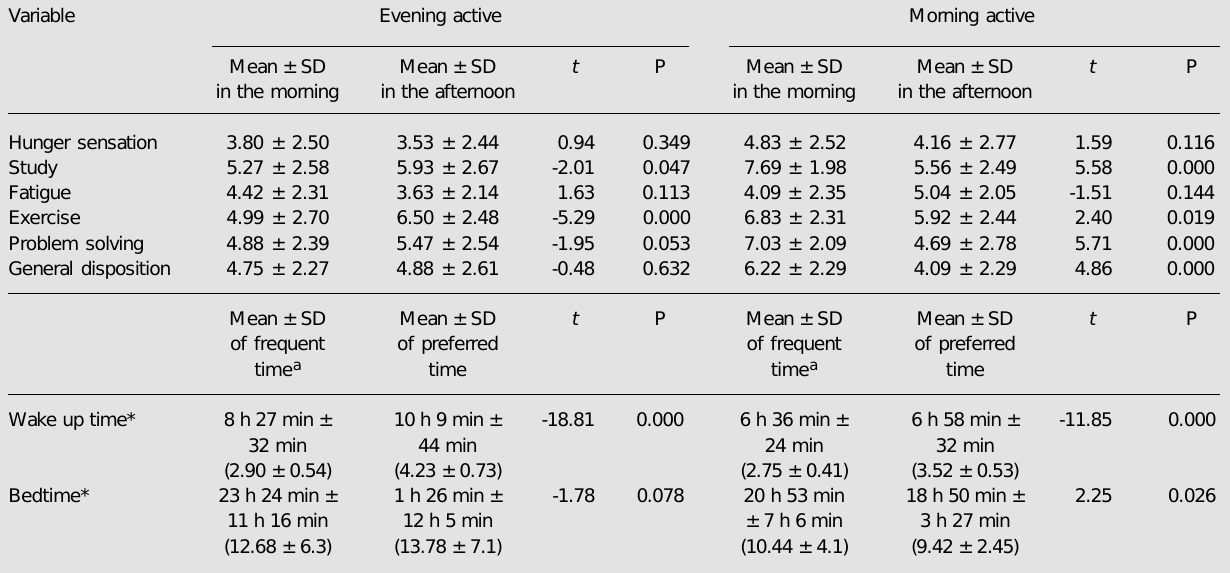
Table 2. Comparison of time behaviors within morning and evening active individuals. Variable